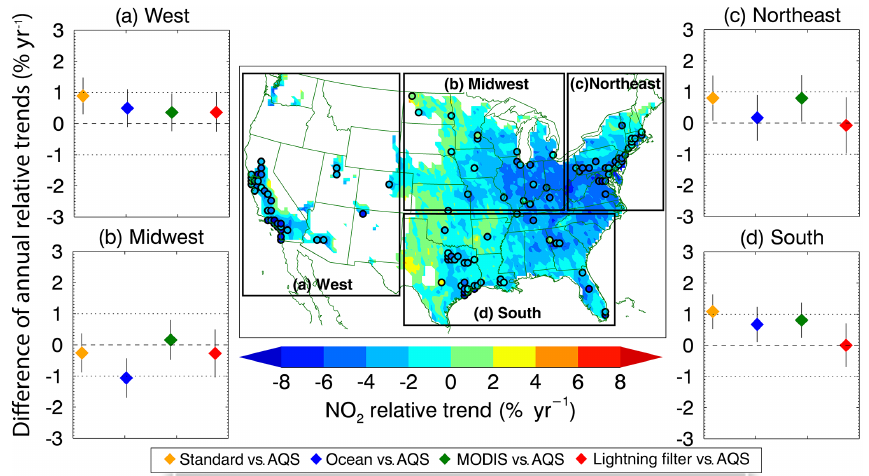
Figure 1. The solid black borders in the center map define the four regions used in this study. The colored background shows the OMI-based NO 2 annual relative trends of the “lightning filter” data. Grid cells with 2005–2014 mean NO 2 VCD values <1 × 10 15 moleculescm − 2 are excluded in this study and are shown in white. The black-bordered circles represent the locations of AQS sites. Panel (a) through (d) show the regional difference (OMI-based relative trends minus AQS relative trends) of annual relative trends between coincident OMI-based and AQS in situ data. The colored diamonds are for “standard” (orange), “ocean” (blue), “MODIS” (green), and “lightning filter” (red) OMI data. The different OMI VCD data are described in Sect.